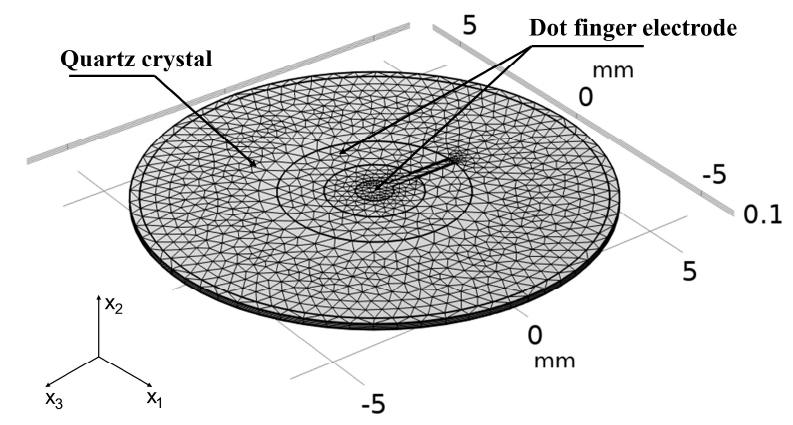
Figure 2. Structure of interdigital electrode. ( a ) Single finger electrode. ( b ) Dot finger electrode. ( c ) Dot double-finger electrode.